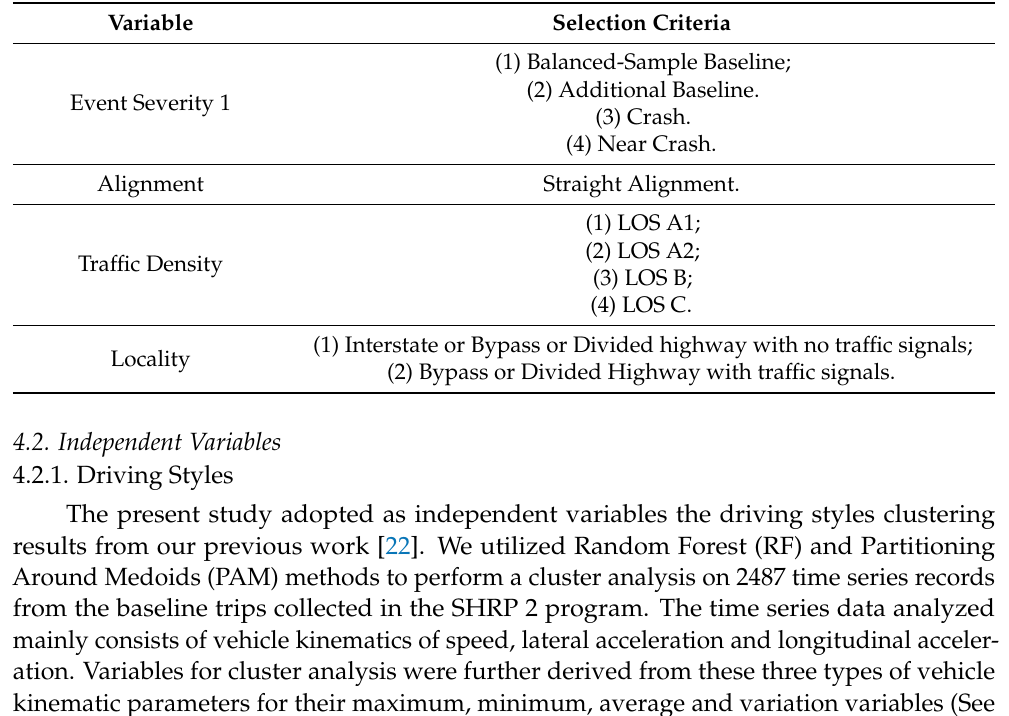
Table 1. Data selection criteria for baseline trips and safety critical events. (Adapted from Event Detail Table Data Dictionary [36], available at https://insight.shrp2nds.us/, accessed on 12 December 2017).